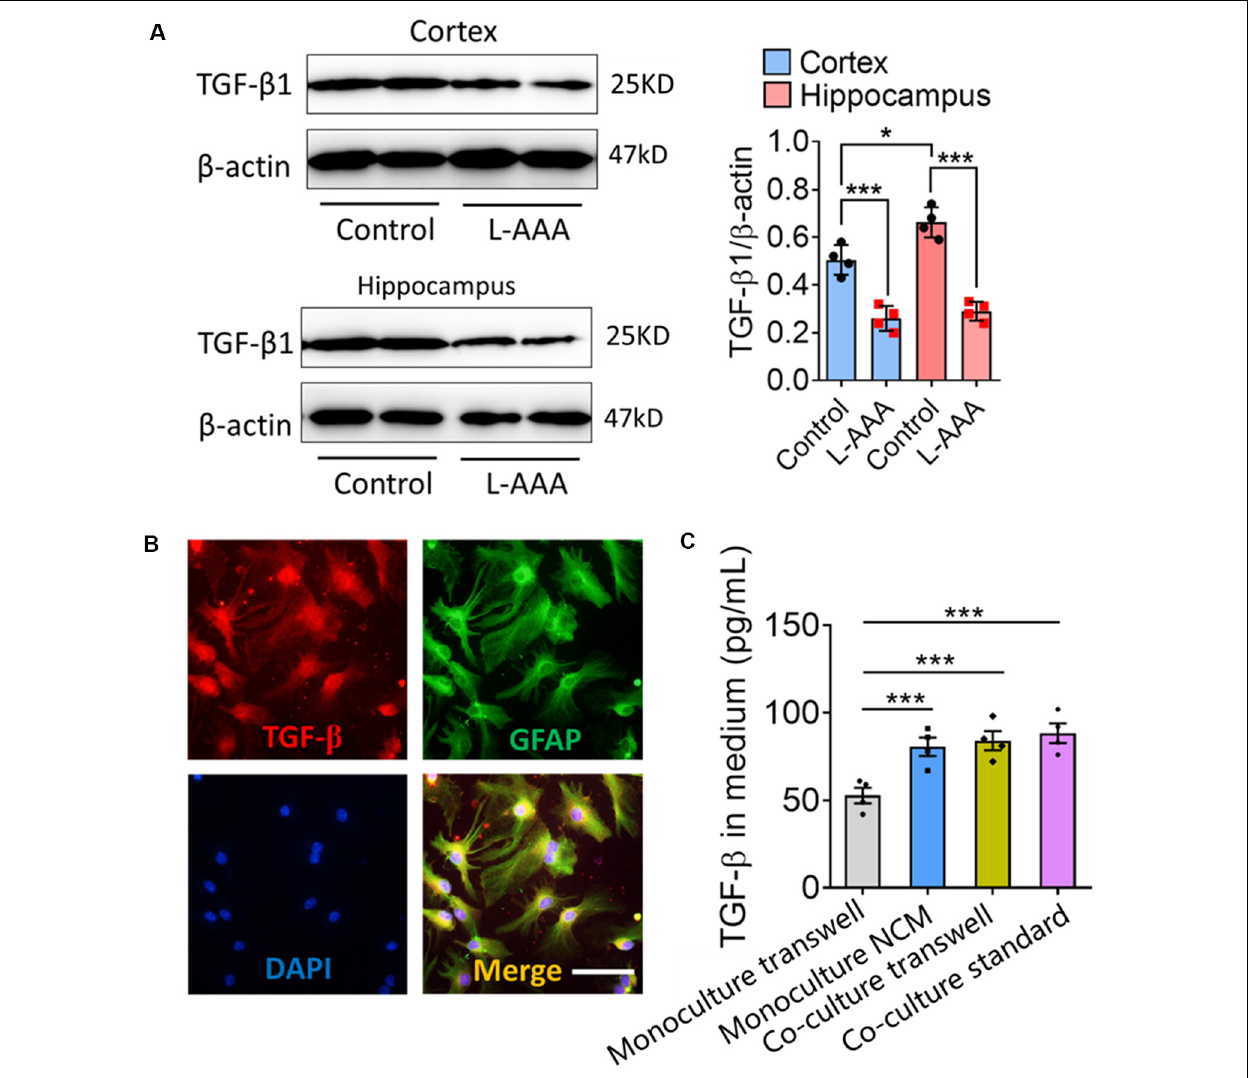
FIGURE 6 | Astrocytes regulate the expression and secretion of TGF- β in vivo and in vitro . (A) Western blots showing TGF- β 1 levels in the hippocampus and cortex from L-AAA-treated or control mice. TGF- β 1 levels were normalized to those of β -actin. Data are mean ± SEM ( n = 4/group). * P < 0.05 and *** P < 0.005 (two-way ANOVA with LSD test). (B) Immunofluorescence micrographs showing relative localization of TGF- β and GFAP + cells. Scale bar, 10 µ m. (C) Levels of TGF- β 1 in the medium of microglia cultured alone in fresh medium or ACM, or cocultured with astrocytes in transwell dishes or standard dishes. Results of each group were obtained from four independent simples. Each sample was tested in triplicate and averaged. Data are presented as mean ± SEM, *** P < 0.005 ( n = 4, one-way ANOVA with